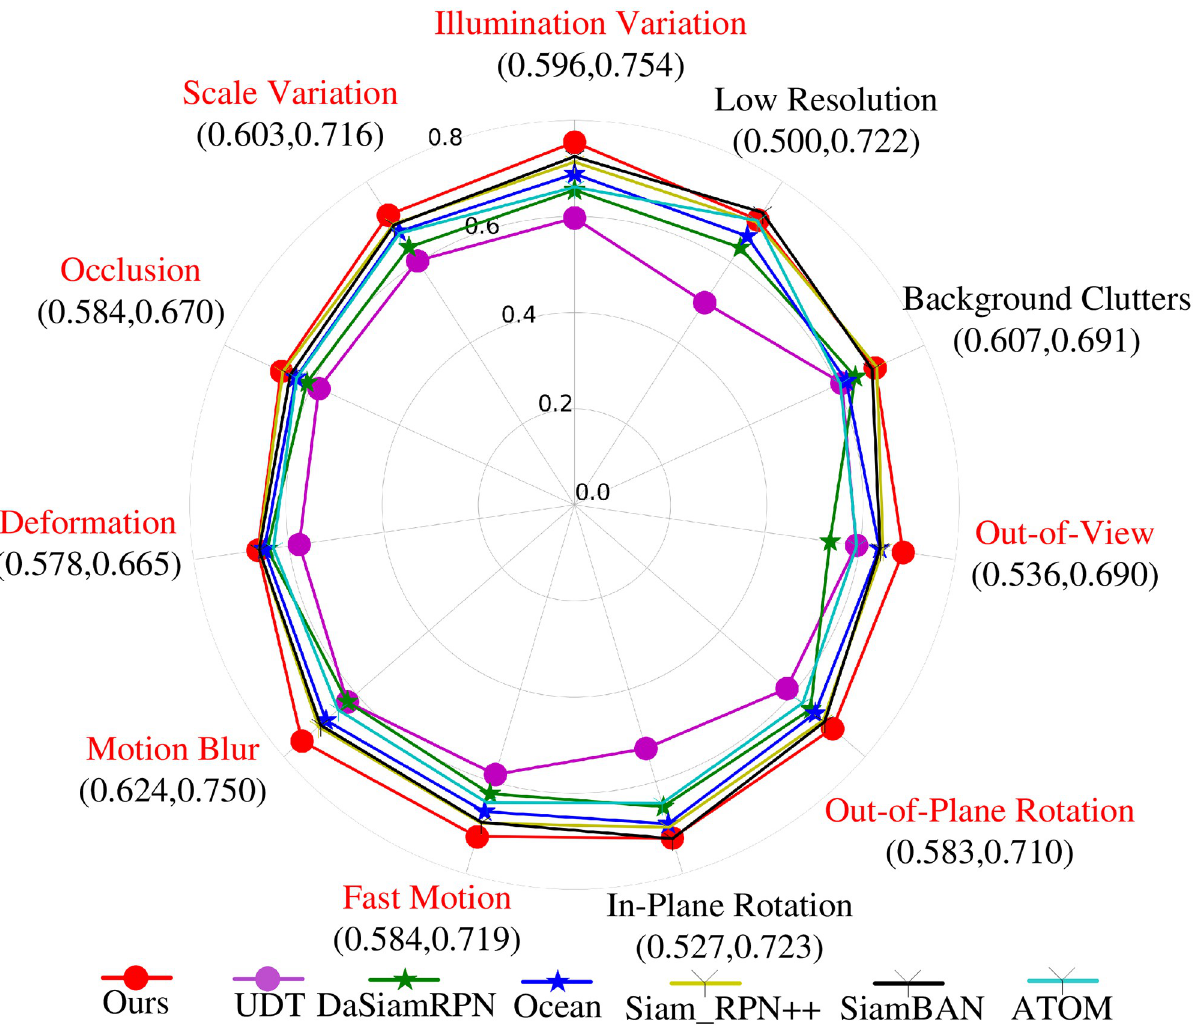
Fig 5. The AUC evaluation index values of each tracker under 11 different challenge factors in OTB-2015.